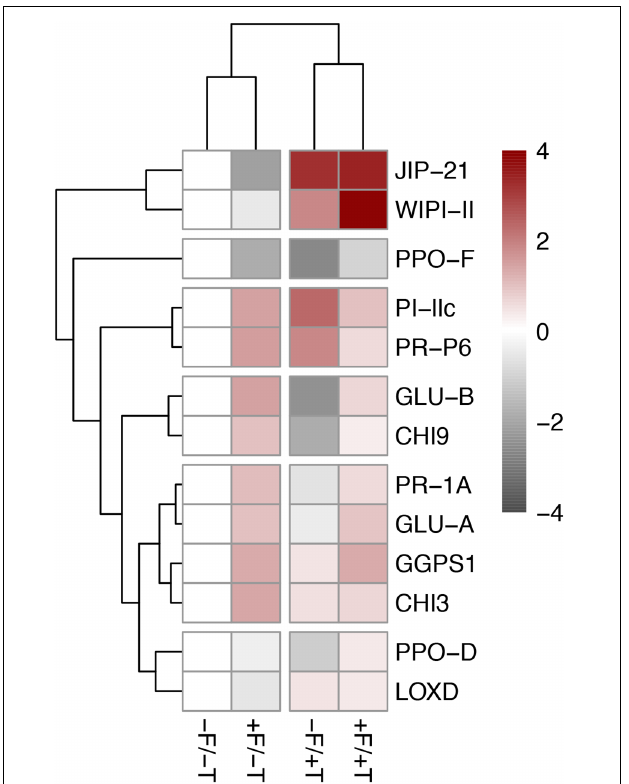
FIGURE 5 | Heatmap of the differentially expressed plant defense genes in tomato plants colonized by the endophyte F. solani strain K (+F) and/or infested with spider mites ( T. urticae , +T) compared with the untreated control (–F/–T). Pink indicates upregulation of gene expression levels and a strong up-regulation is indicated in dark red. Light gray indicates downregulation and dark gray indicated strong downregulation of gene expression levels. White indicates the control group. The sample/gene grouping is based on hierarchical clustering (complete linkage algorithm) of the Euclidean sample/gene distances of the differentially expressed genes detected by ANOVA (Tukey’s post hoc tests, P < 0.05). Values are the mean fold-change compared to relative gene expression in the control plants (–F/–T) of two technical replicates for each of six biological replicates. Expression levels for all target genes were normalized to the geometric mean of ubiquitin and actin expression levels in each sample as a reference. Values and statistically significant differences compared to control samples are presented in Supplementary Table S2 . JIP-21 , WIPI-II , PPO-F/D , PI-IIc, and LOX-D are JA-marker genes; PR-P6 and PR-1A are SA-marker genes; GLU-A/B and CHI3/9 are fungal (or herbivore, e.g., whitefly)-marker genes (see relevant references in